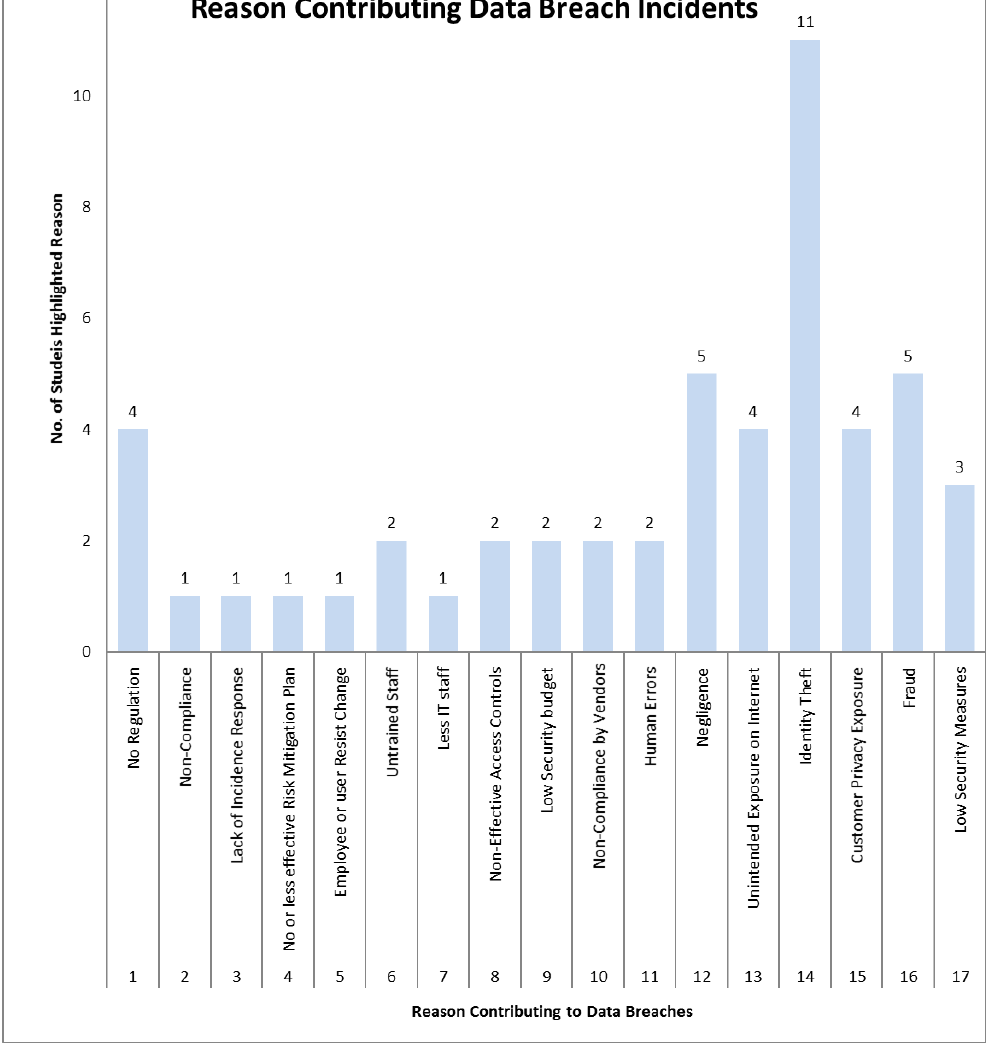
Figure 6. Graphical view of reasons contributing to data